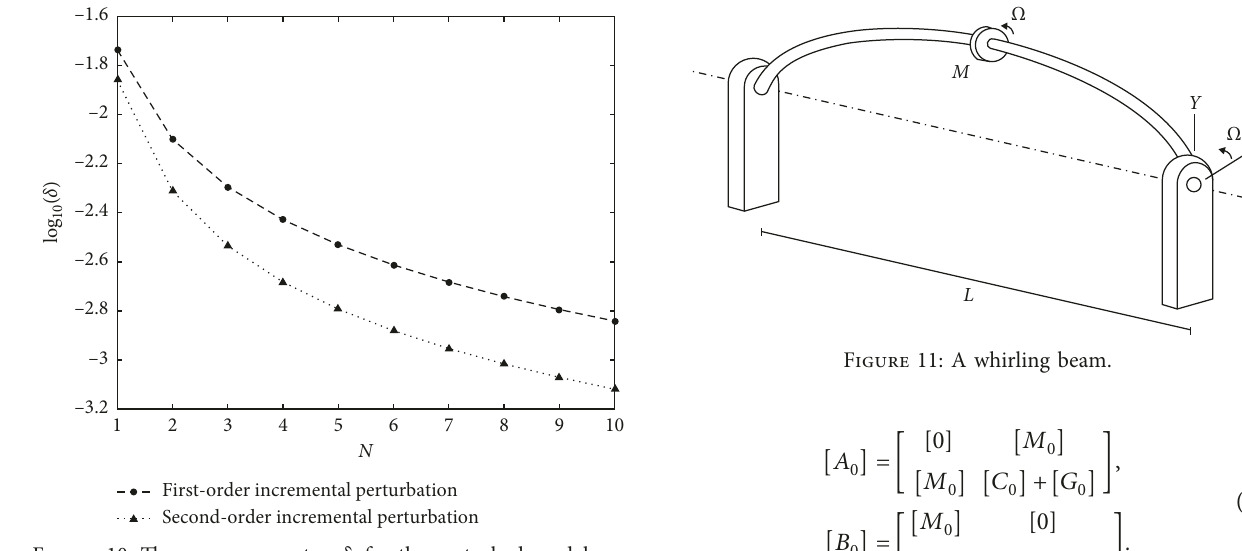
Figure 10: The error parameter, δ , for the perturbed modal ma- trices of the two-degree-of-freedom gyroscopic system as a func- tion of N for σ 1 . 37. (cid:31)